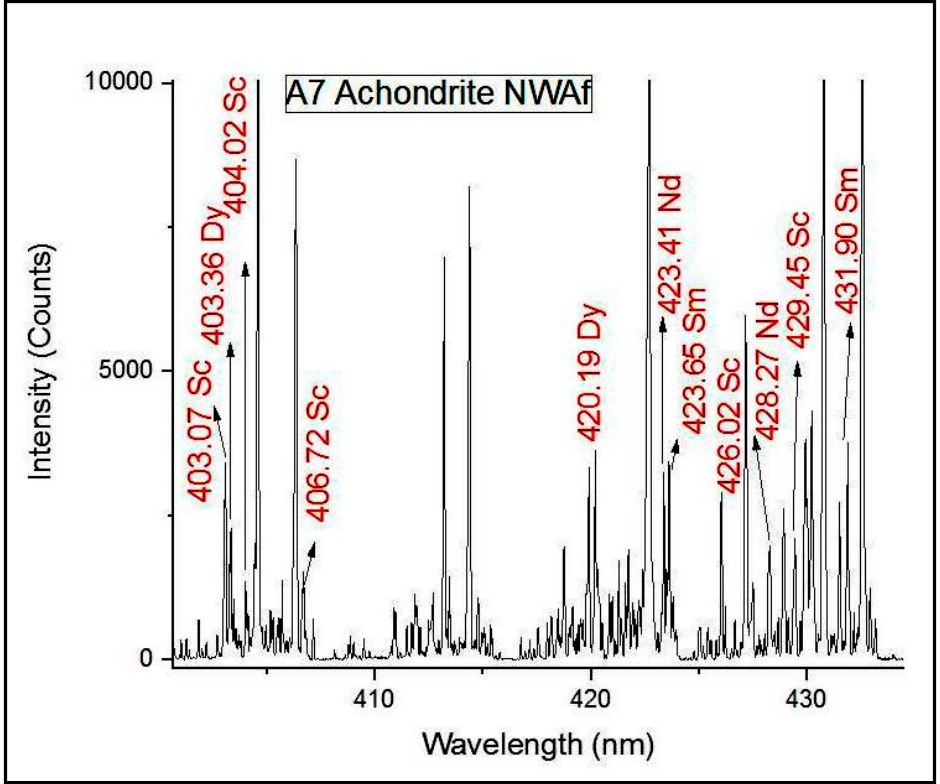
Figure 9. REEs identified in LIBS spectrum of Samples A7 in selected wavelength range.